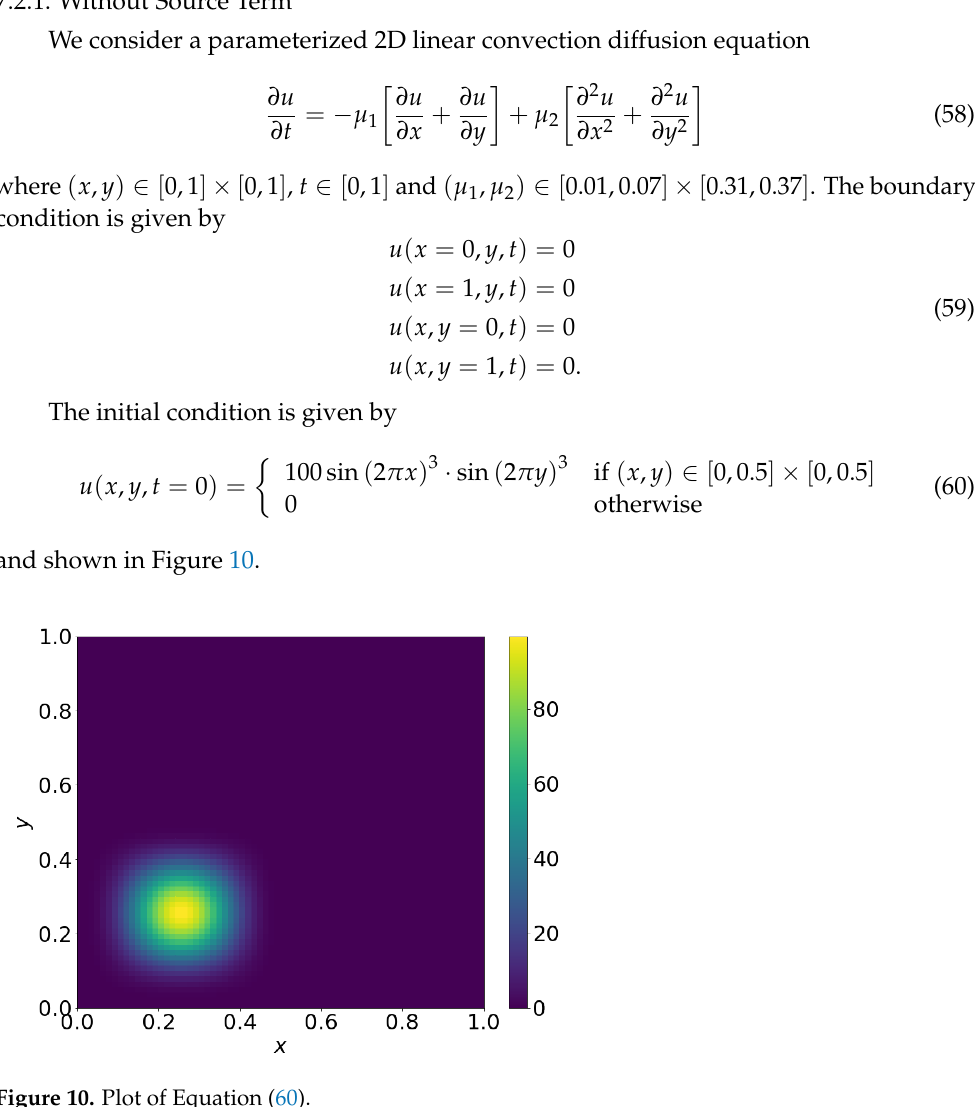
Figure 10. Plot of Equation